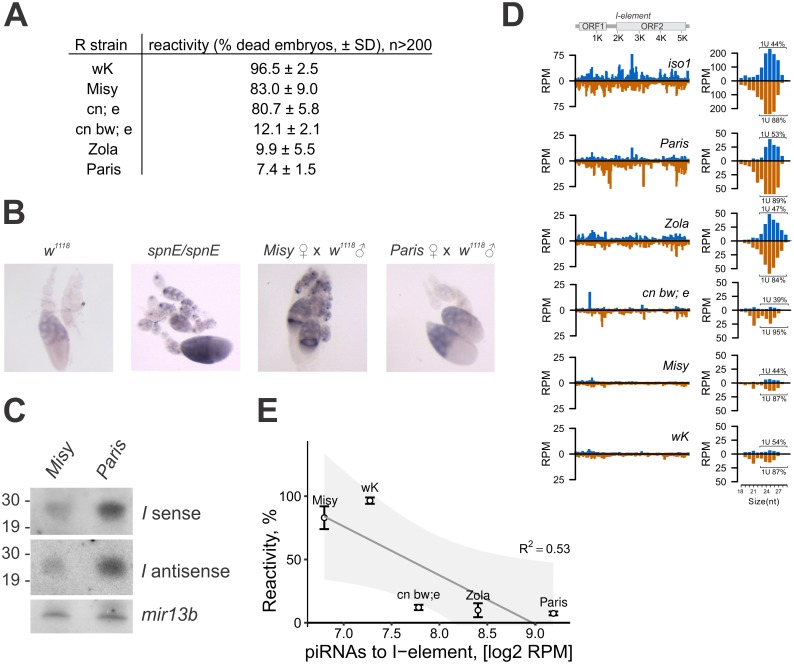
Abundance of I-element-specific piRNA correlates with the reactivity of R strains.(A) Reactivity of R strains measured as a percent of non-hatched embryos. Standard deviation (SD) for three replicates is shown; n designates the number of embryos analyzed. (B) Different manifestation of hybrid dysgenesis for Misy (strong) and Paris (weak) R strain. spnE/spnE is a transheterozygous spindle-E mutants (spn-E1/spn-Ehls3987). RNA in situ hybridization of ovaries with I-antisense riboprobe is shown. (C) Weak R strain produces more abundant I-element specific piRNA. Northern analysis of the RNA isolated from ovaries of Paris and Misy strains. Hybridization was done with I-element riboprobes to detect sense (I sense) and antisense (I antisense) piRNAs. Lower panel represents hybridization to mir-13b1 microRNA. P32-labeled RNA oligonucleotides were used as size markers. (D) I-element specific small RNA mapping to canonical I-element. Analysis of ovarian small RNA libraries from strong (Misy and wK) and weak (Paris, Zola, cn bw;e) R strains (0–3 mismatches allowed). Reads mapped to the sense strand are shown in blue, and antisense in brown. Length distribution of small RNAs mapping to I-element is plotted on the right. Percentages of reads having 1U bias are indicated for each strand (only 24–29 nt reads were considered) (E) Negative correlation between reactivity and I-element specific piRNA counts for R strains. Spearman correlation tests: r = -0.90, P-value <0.1. The line depicts the results of linear regression analysis for the level of reactivity and amount of piRNAs. R2—adjusted squared R (P-value < 0.1); the grey zone illustrates the 90% confidence interval.